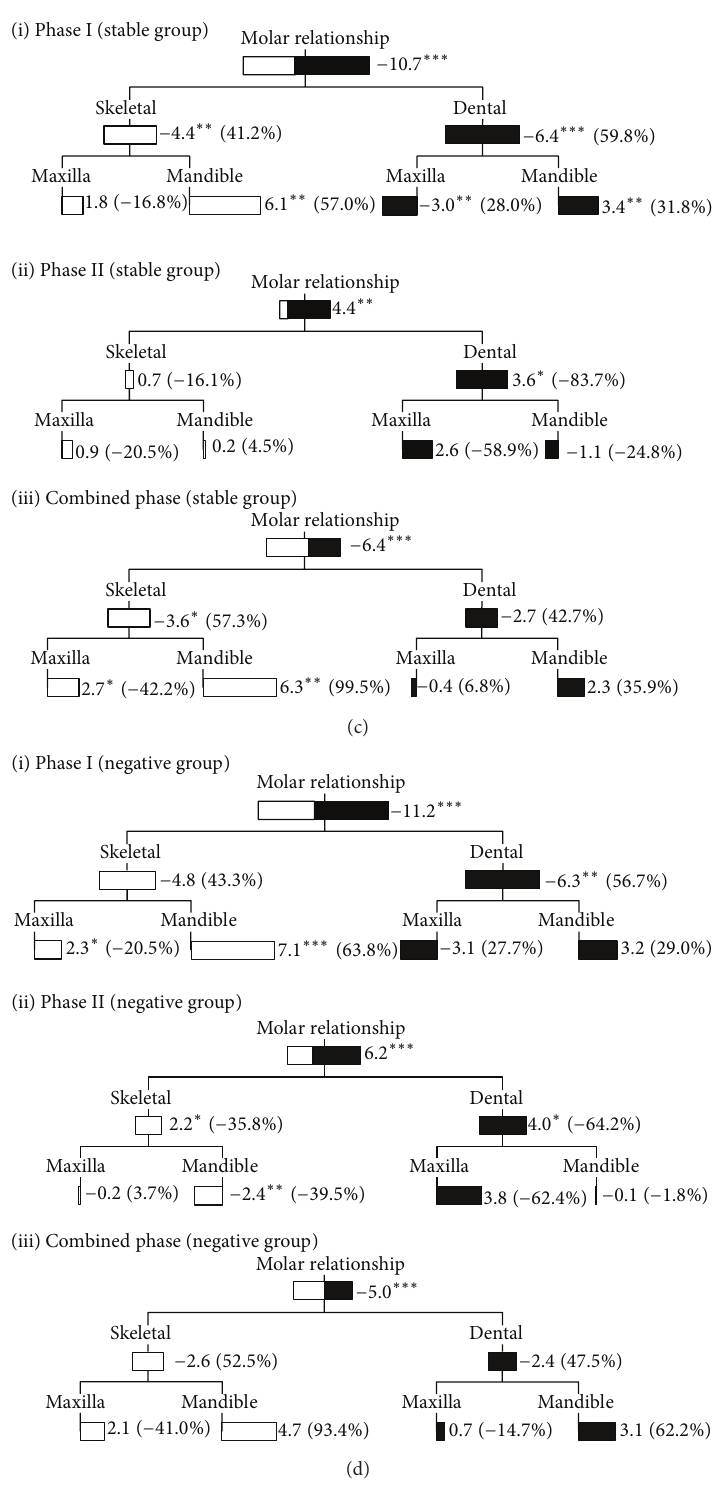
Figure3:Molarcorrectionof(a)thewholestudysample,(b)positivegrowthgroup,(c)stablegrowthgroup,and(d)negativegrowthgroupfor phase I (T0-T1), phase II (T1-T2), and the total treatment period (T0–T2) in the positive growth group ( ∗ 𝑃 < 0.05 ; ∗∗ 𝑃 < 0.01 ; ∗∗∗ 𝑃 < 0.001